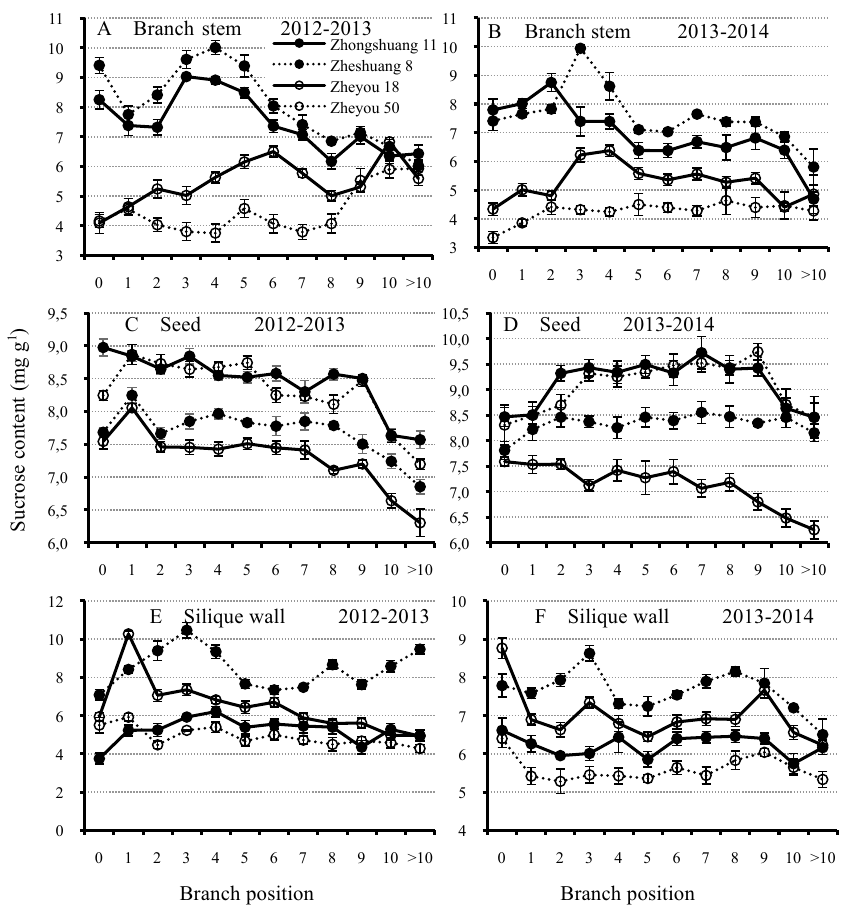
Fig. 4: Sucrose content in the main inflorescence and different branches from the top to the bottom of the main stem in the branch stem in (A) 2012-2013 and (B) 2013-2014, seed in (C) 2012-2013 and (D) 2013-2014, and silique wall in (E) 2012-2013 and (F) 2013-2014 growth seasons in the four cultivars, Zheyou 50, Zhongshuang 11, Zheyou 18, and Zheshuang